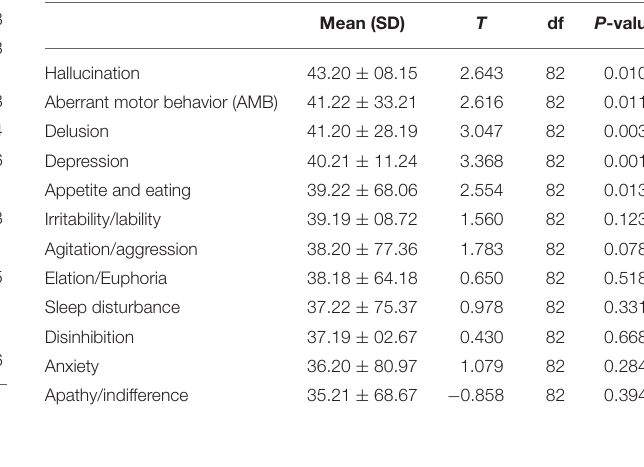
TABLE 3 | The relationship between the mean score of neuropsychoatric symptoms (NPS), total caregiver burden (CB) score, and sub-components of CB. Components